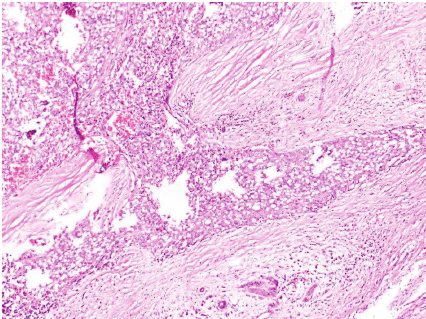
Figure 5: Haematoxylin and eosin stained sections revealing foci of pseudopapillae and rosettes with vascular cores lined by neoplastic cells ( × 400).